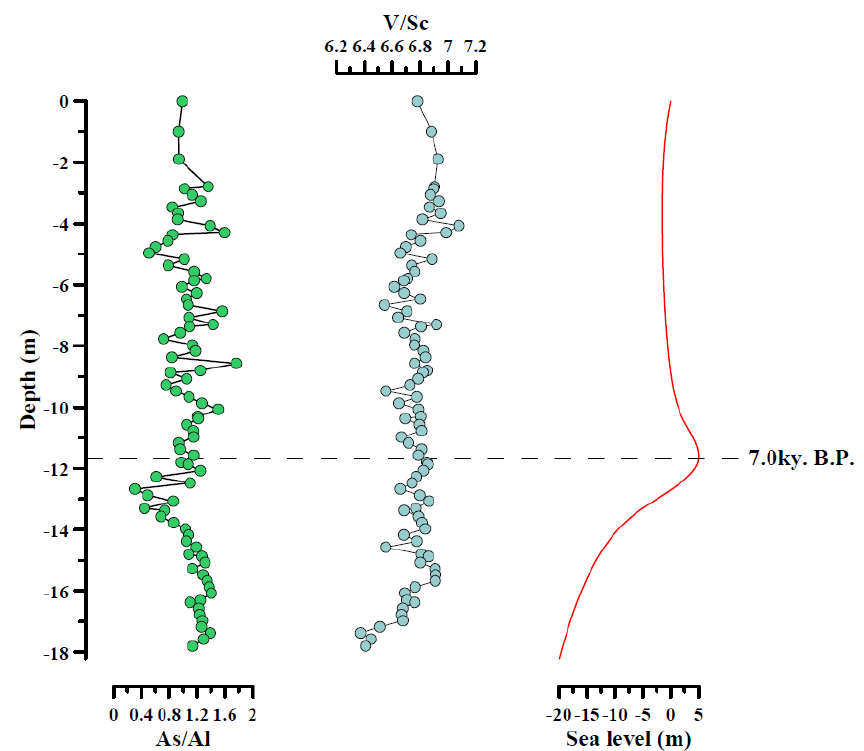
Figure 10. The vertical distribution of geochemical index of As/Al and V/Sc.